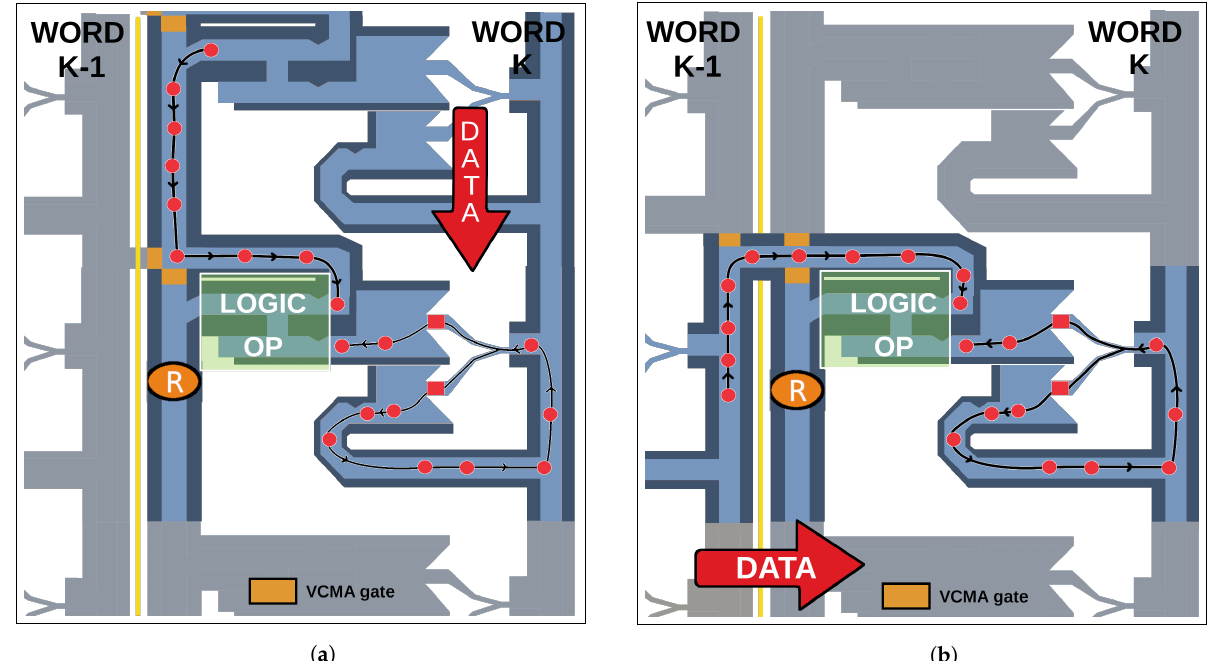
Figure 8. Logical operation between rows and columns. ( a ) Column-wise operation and ( b ) row-wise